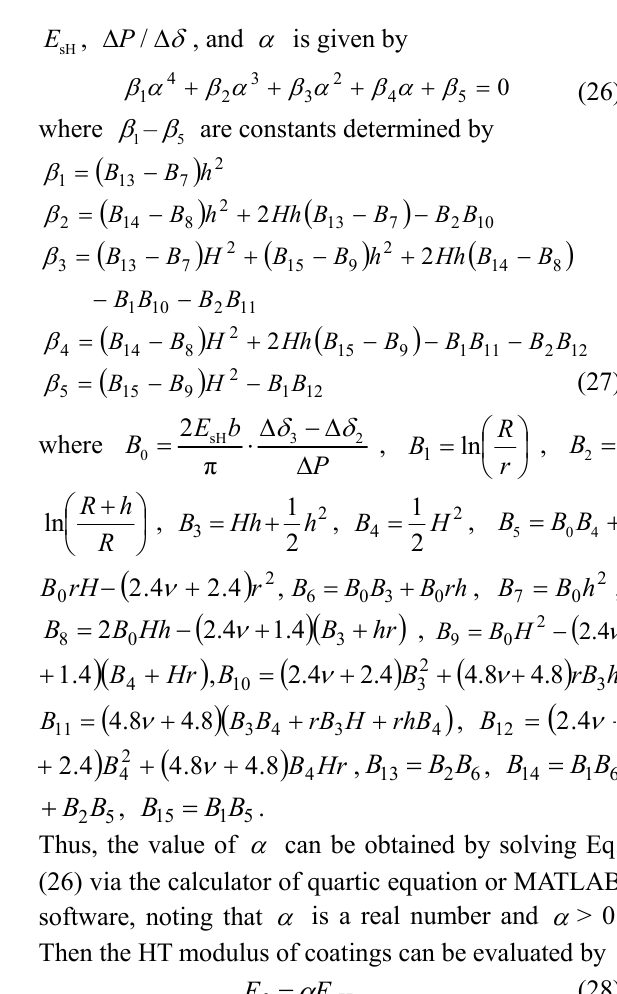
Fig. 7 Schematic illustration of split ring specimen with (a) outer-side coating, (b) inner-side coating, and (c) double-side